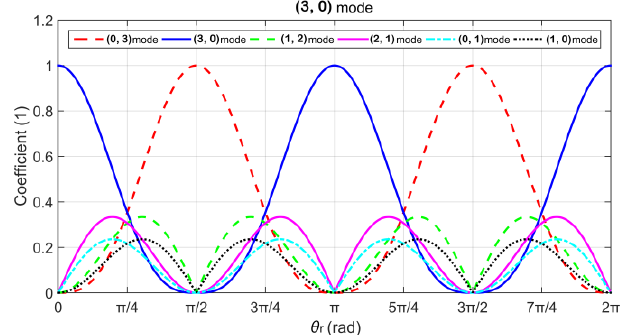
Figure 4. Coefficients of new modes varying with the rotation angle 𝜃 r in the example of (3,0) mode.